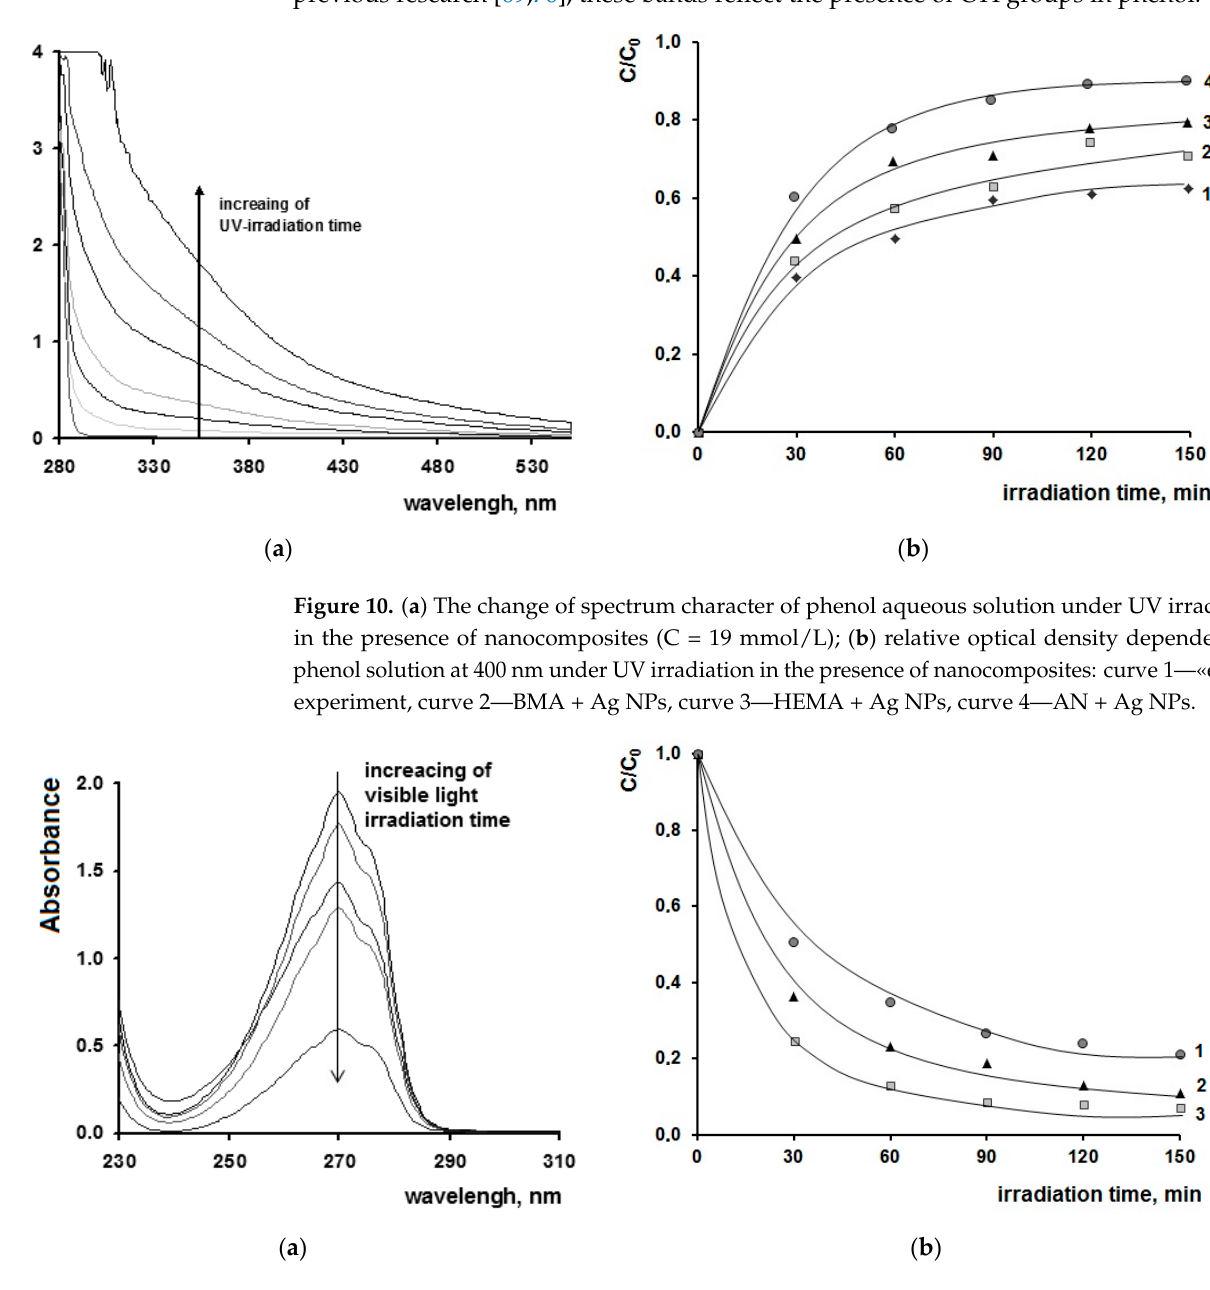
Figure 11. ( a ) The change in the nature of the aqueous solution spectrum of phenol at its irradiation with visible light in the presence of nanocomposites; ( b ) the dependence of the relative concentra- tion of phenol in the solution under irradiation of visible light in the presence of nanocomposites of